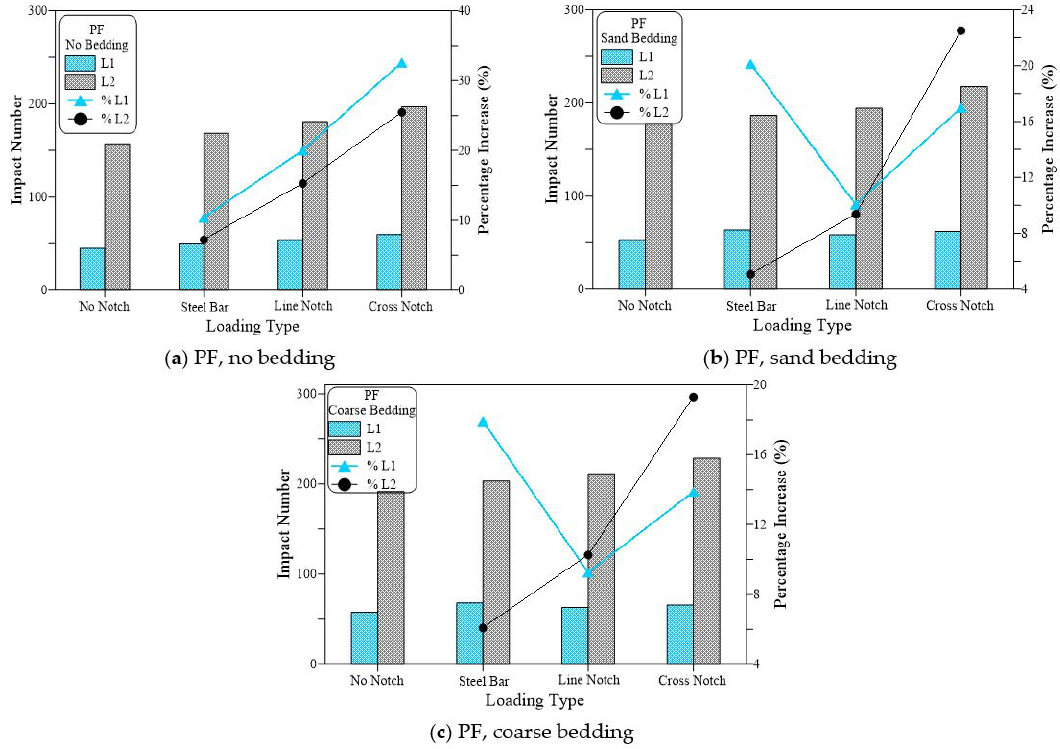
Figure 14. Loading type effect on cracking and failure impact numbers of PF specimens. ( a ) PF, no bedding, ( b ) PF, sand bedding ( c ) PF, coarse